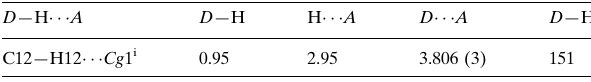
Hydrogen-bond geometry (A˚ , (cid:1) ). Cg 1 is the centroid of the C3–C8